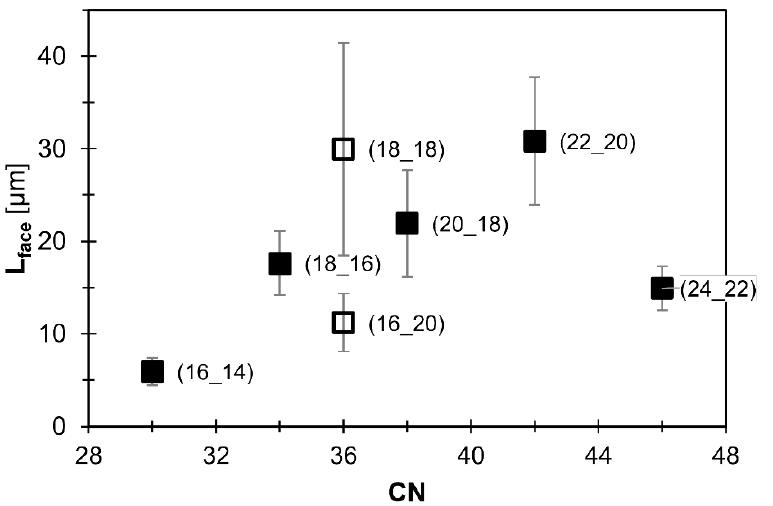
Figure 8. L face of WE crystals in oleogels containing MCT oil and 10% [ m / m ] of WE (different CN) as a function of CN. L face was determined using measurement of the ten longest straight faces. The oleogel samples were crystallized at a cooling rate of 5 K/min. Filled squares: homologous series of ∆ CN = + 2, hollow squares: not part of the homologous series. All WE are denoted as (FaOH_FA).